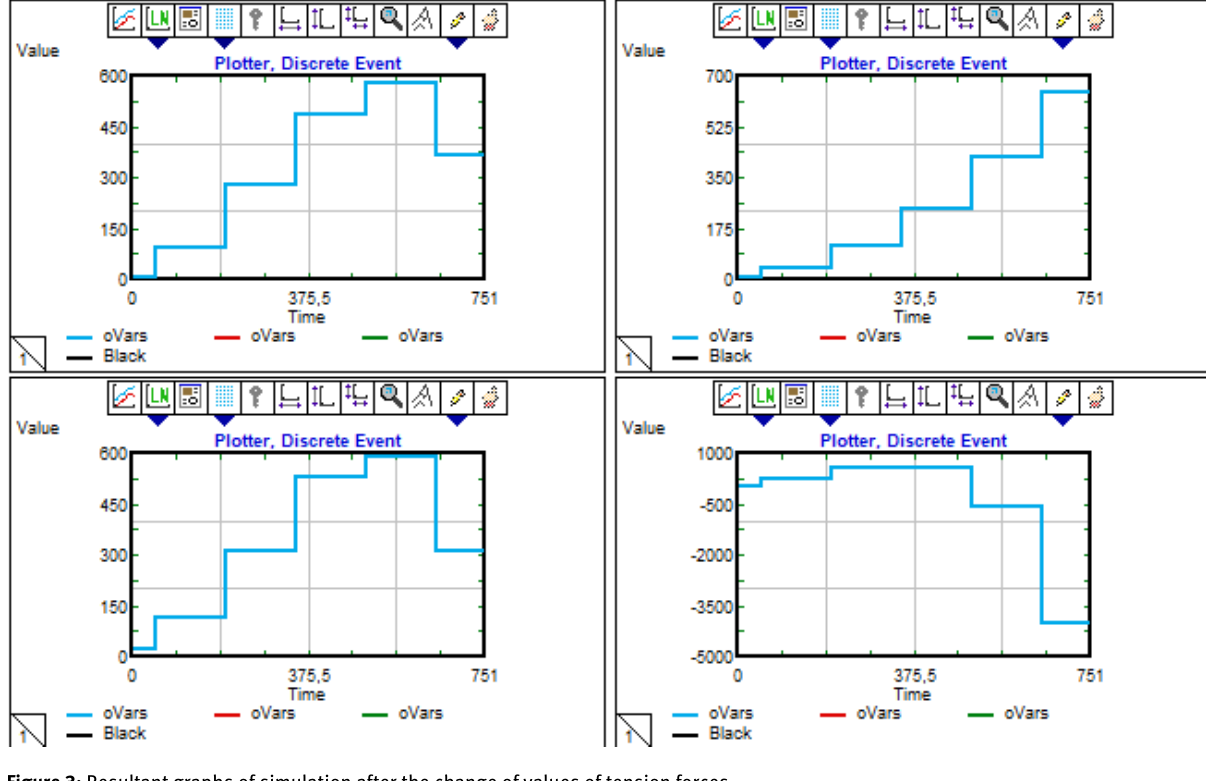
Figure 3: Resultant graphs of simulation after the change of values of tension forces